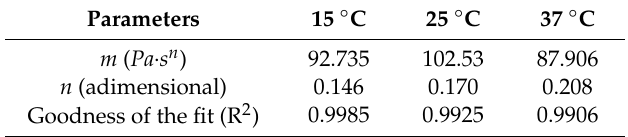
Table 1. Consistency index ( m ) and flow behavior index ( n ) of Cellink Bioink at 15, 25, and 37 ◦